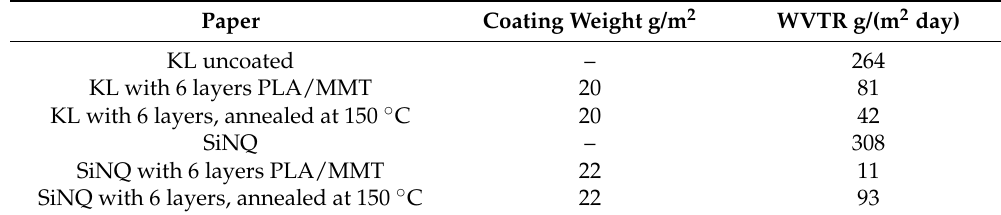
Table 3. WVTR of uncoated and coated papers. KL, Kraft Lux, SiNQ, Silico